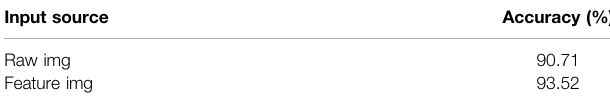
TABLE 4 | results of the different input sources.